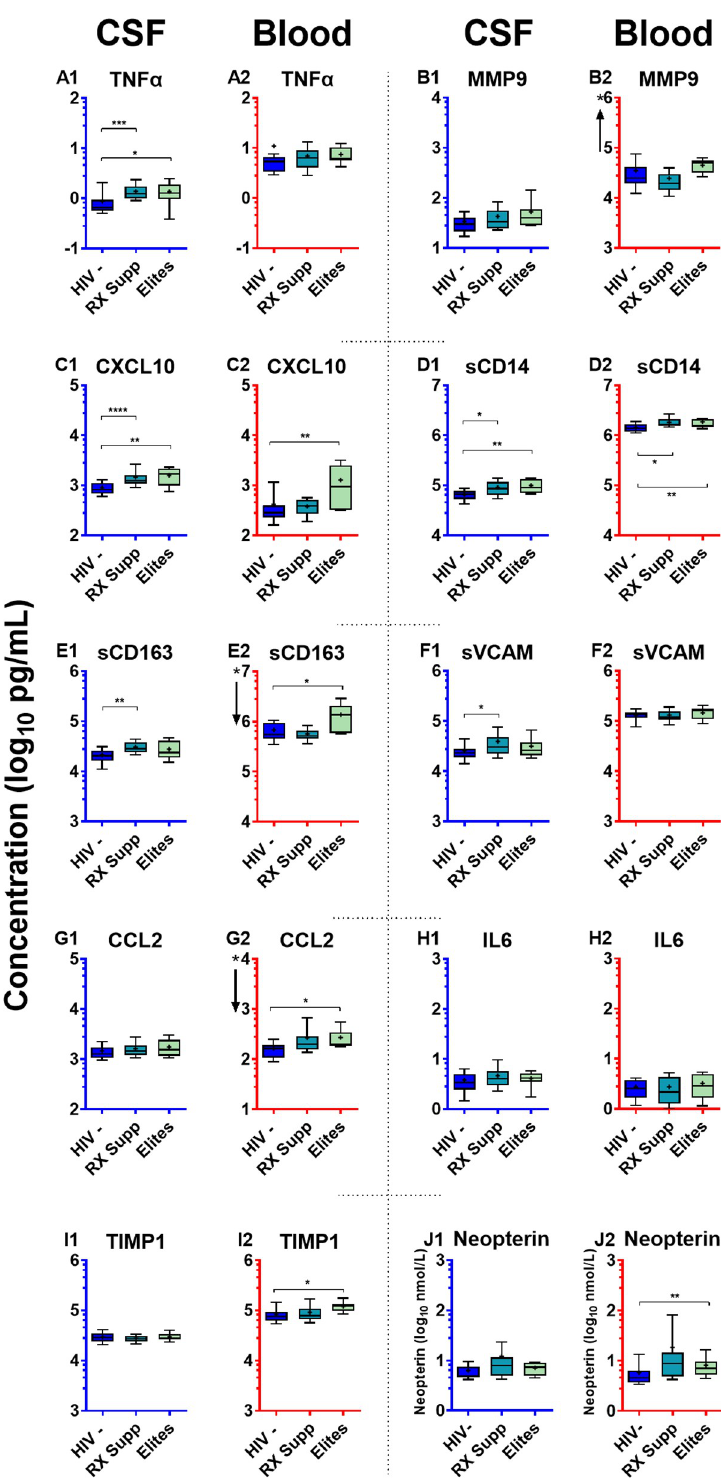
Fig 7. CSF and blood inflammatory biomarkers in ART-suppressed and elite controllers. Inflammatory biomarkers in the two virally suppressed groups are compared to HIV-uninfected controls. These graphs use the same format, axes and unit scales as Fig 1 but show the isolated data of the HIV negatives, treated-suppressed and elites, with each of the latter two groups compared independently to the HIV negative group with significant differences noted